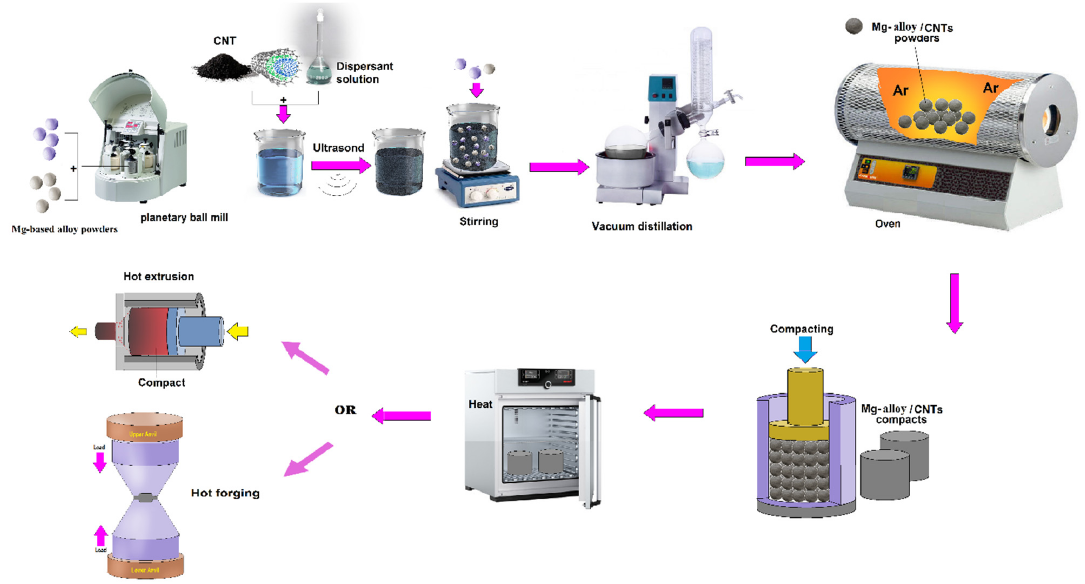
/ CNTs using Gemini